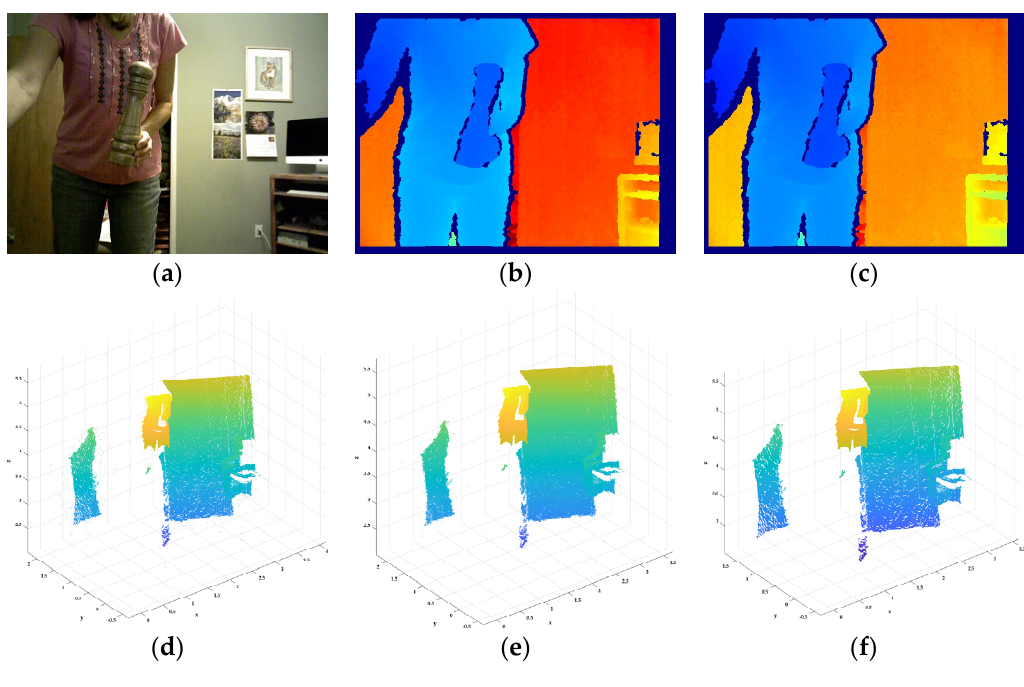
image after median filtering and denoising (PSNR = 36.309 dB).